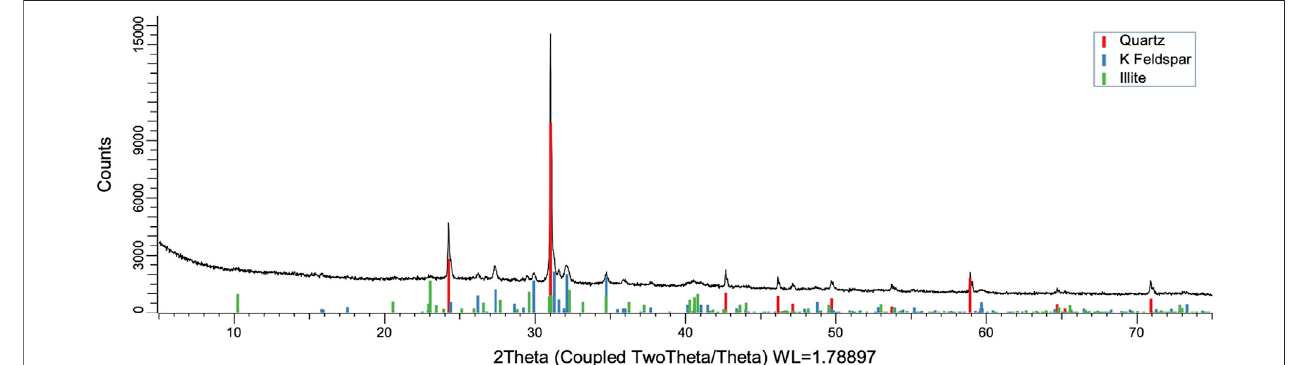
FIGURE 12 | XRD pattern of oxidation residue at 120 ° C and 24